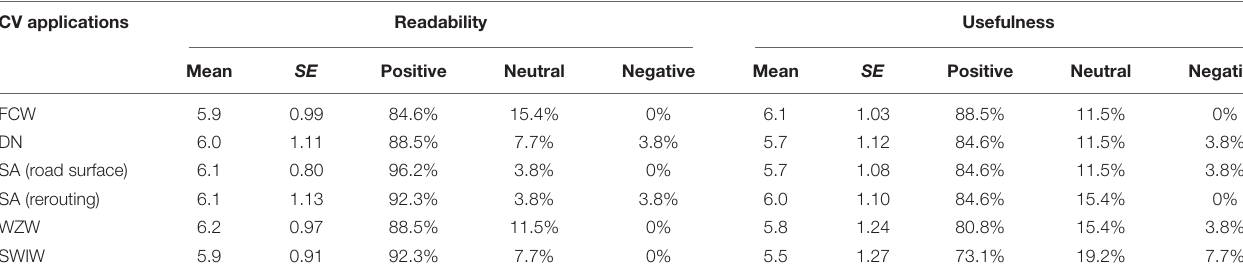
TABLE 3 | Participants’ assessment results of the specific CV applications. CV